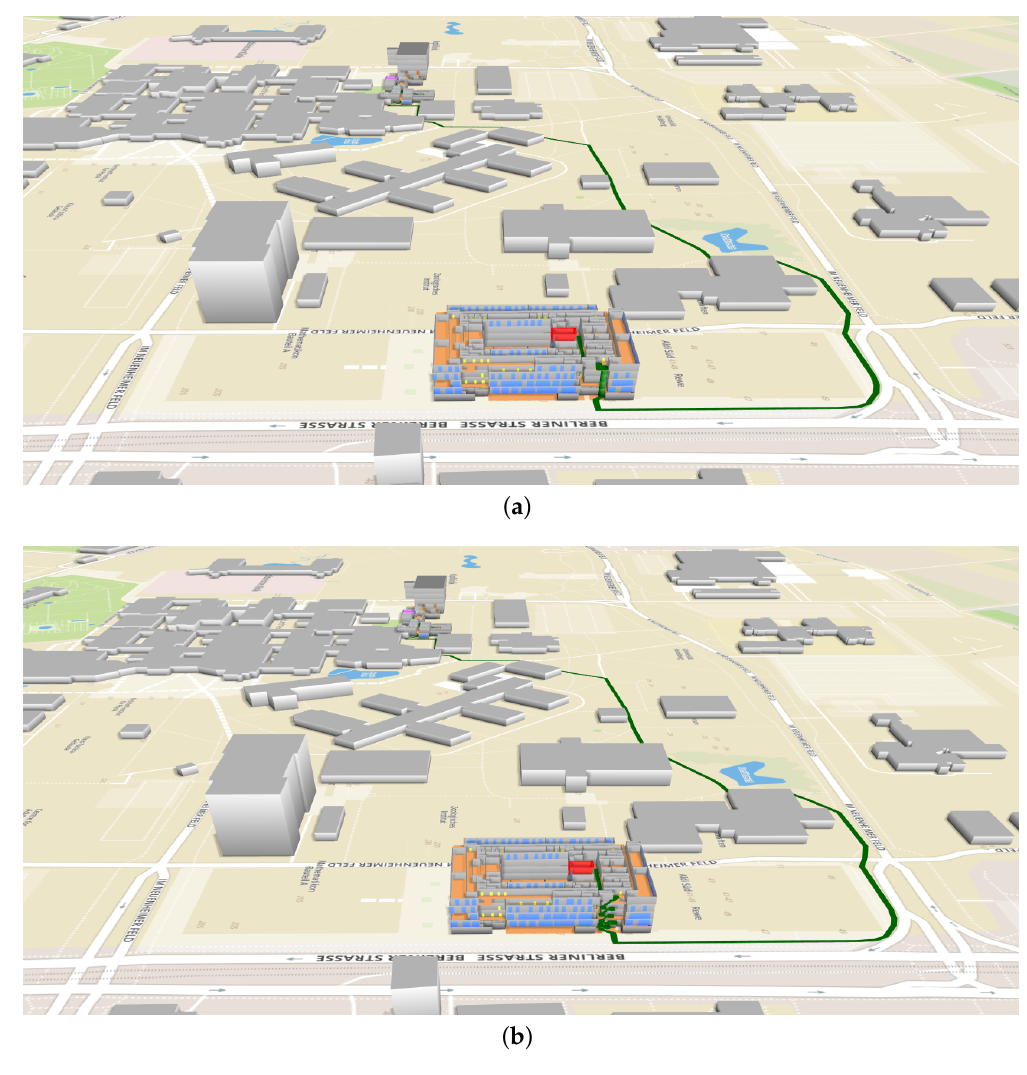
Figure 18. Examples of the calculated routes (in green) from the source room (in red) in the Mathematikon building to the target room (in purple) in the Geography building. The windows and the doors of the buildings are colored in blue and in yellow, respectively. ( a ) R7 (using elevators); ( b ) R8 (without using